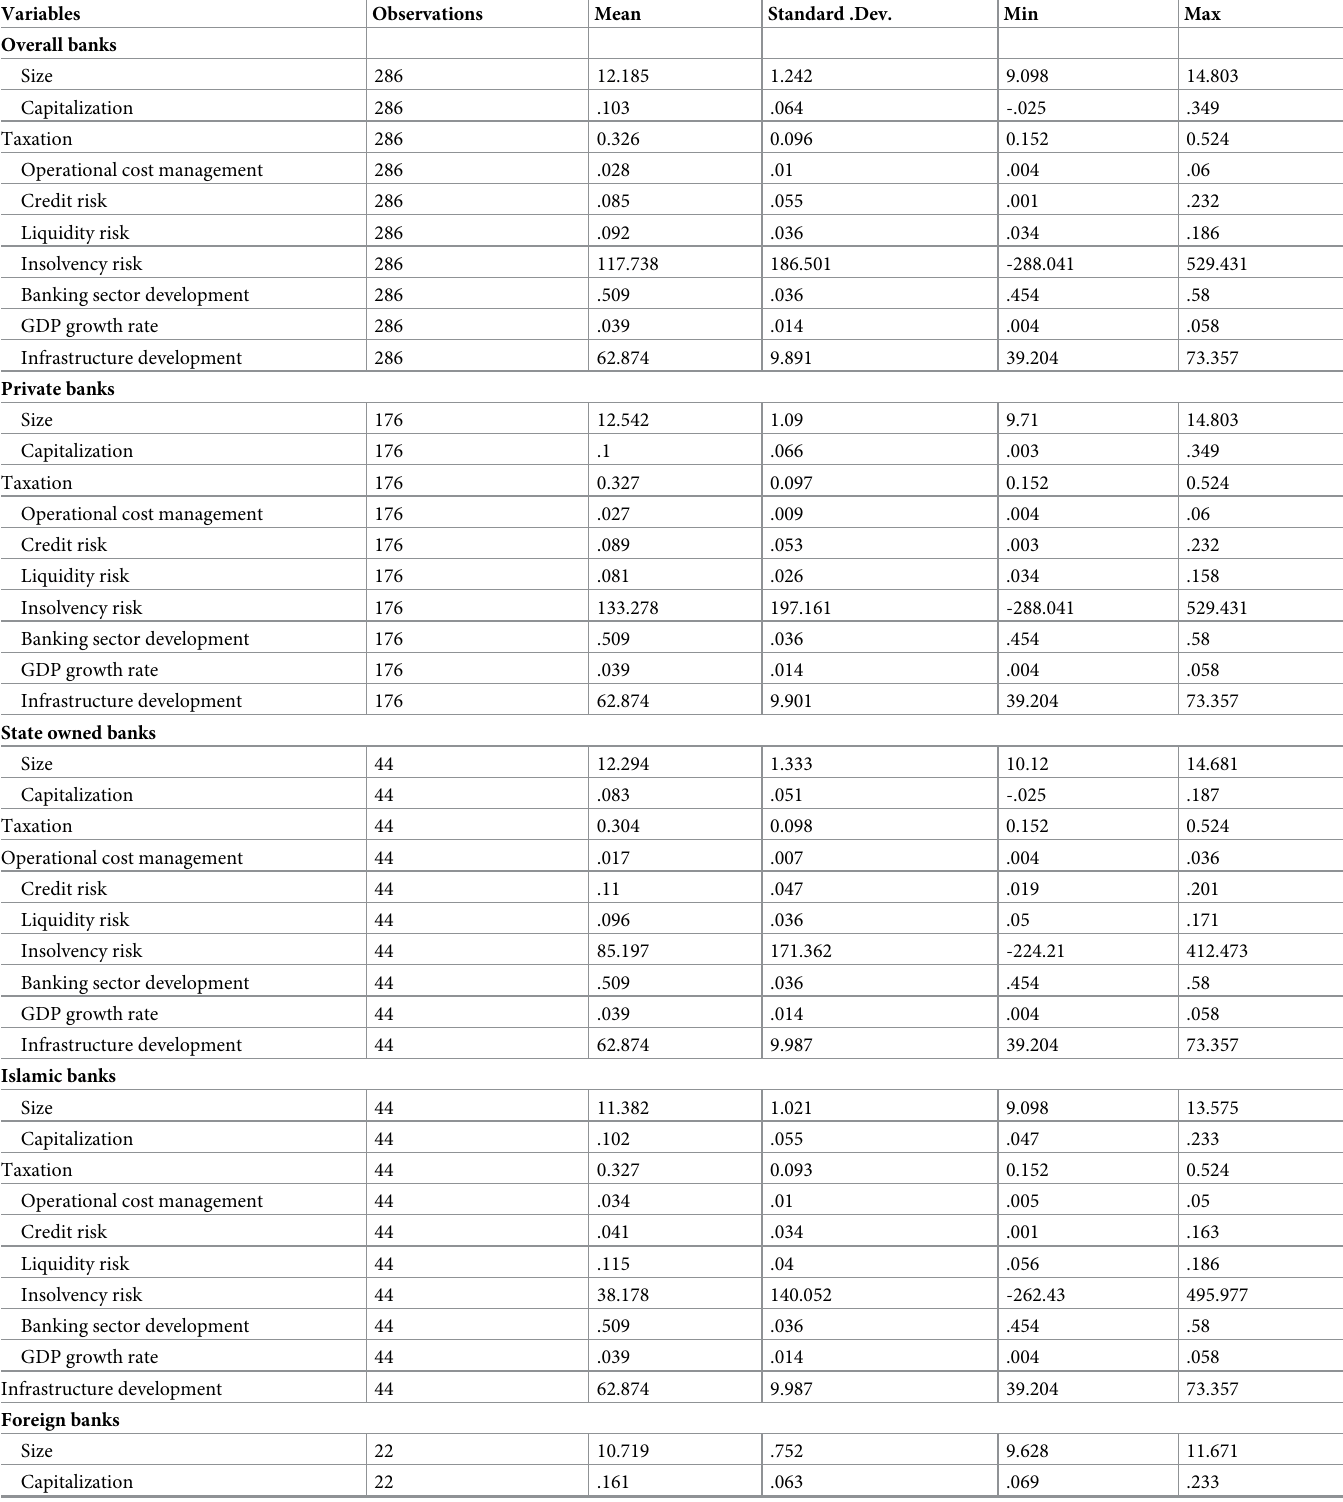
Table 4. Summary statistics of explanatory